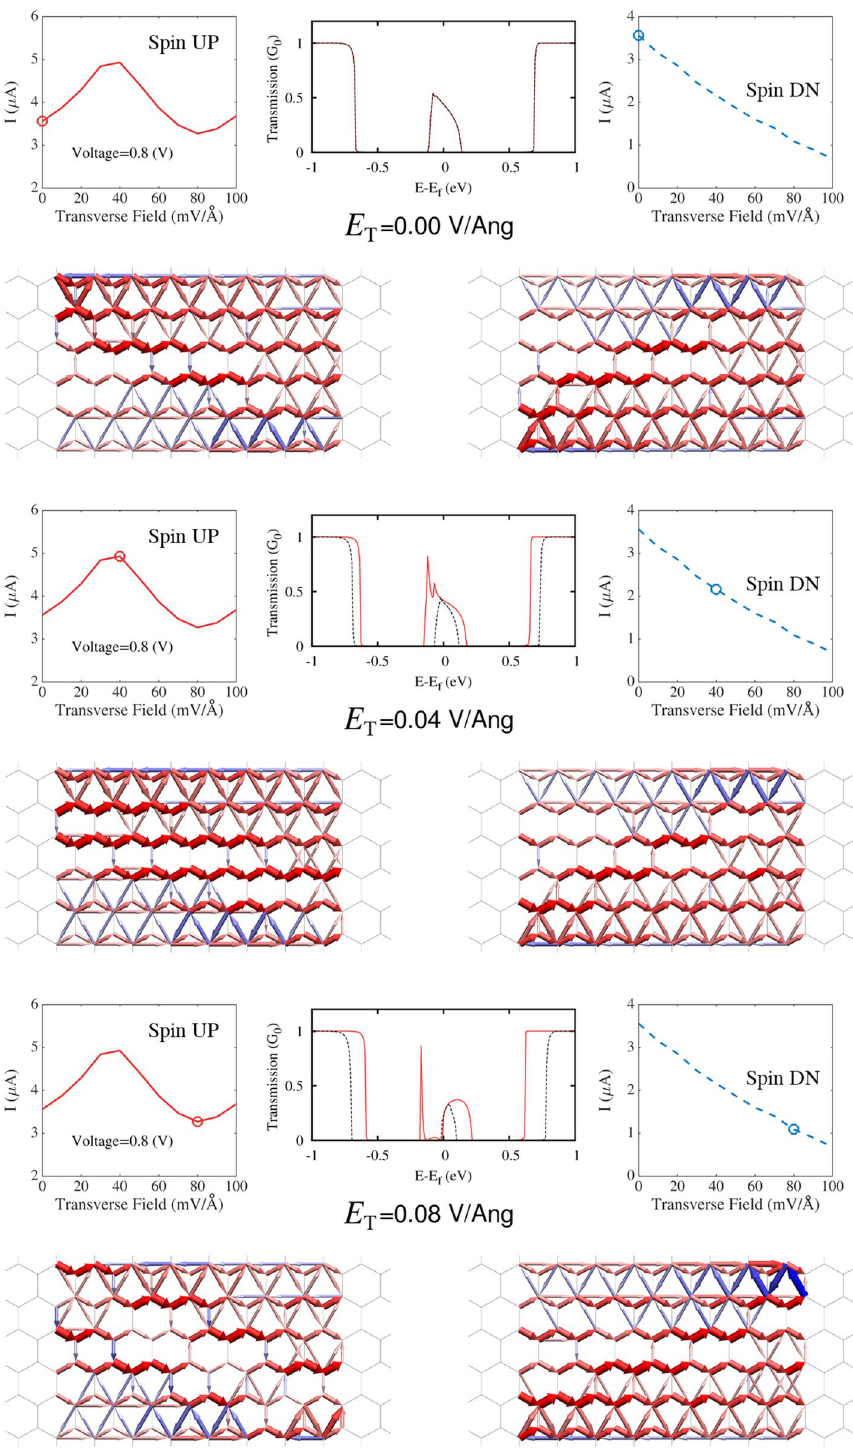
Figure 9. Spin currents, transmission spectra, and transmission pathways for a 6-zGNR at a bias voltage of 0.8V with transverse electric fields of magnitude 0.0 V / Å (top), 0.04 V / Å (middle), and 0.08 V / Å